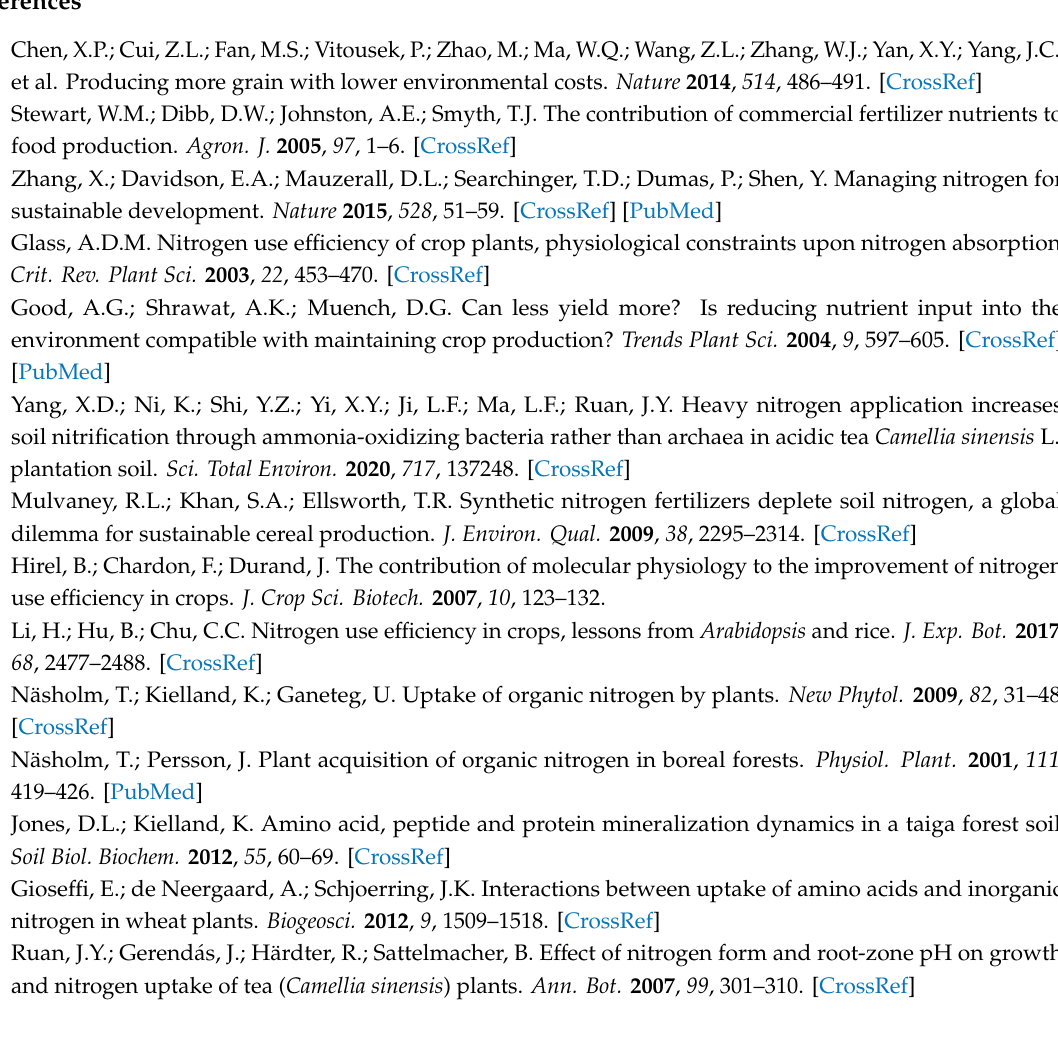
for genes. Figure S7: Expression levels of 28 CsNRT1, two CsNRT2 and five CsAMTs genes in shoots and in roots across the N treatments. Figure S8: Transcript levels of AAT genes in shoots and in roots across the N treatments. Figure S9: Expression levels of key genes involved in N assimilation in shoots and in roots across the N treatments. Figure S10: The NO3 − treatment served as a control of N source for amino acid substrates identification. Figure S11: √ Main N transporters supposed to mediate key transportation processes. ‘ ’ represents the potential candidates and ‘?’ means less possibility. Table S1: General properties of the reads produced by Pacbio RSII sequencing. Table S2: Table S4: Di ff erentially expressed genes identified by DESeq2. Table S5: Primers sequences for qRT-PCR analysis. Table S6: Primers sequence for Arabidopsis homozygous lines identification and CsCAT9.1